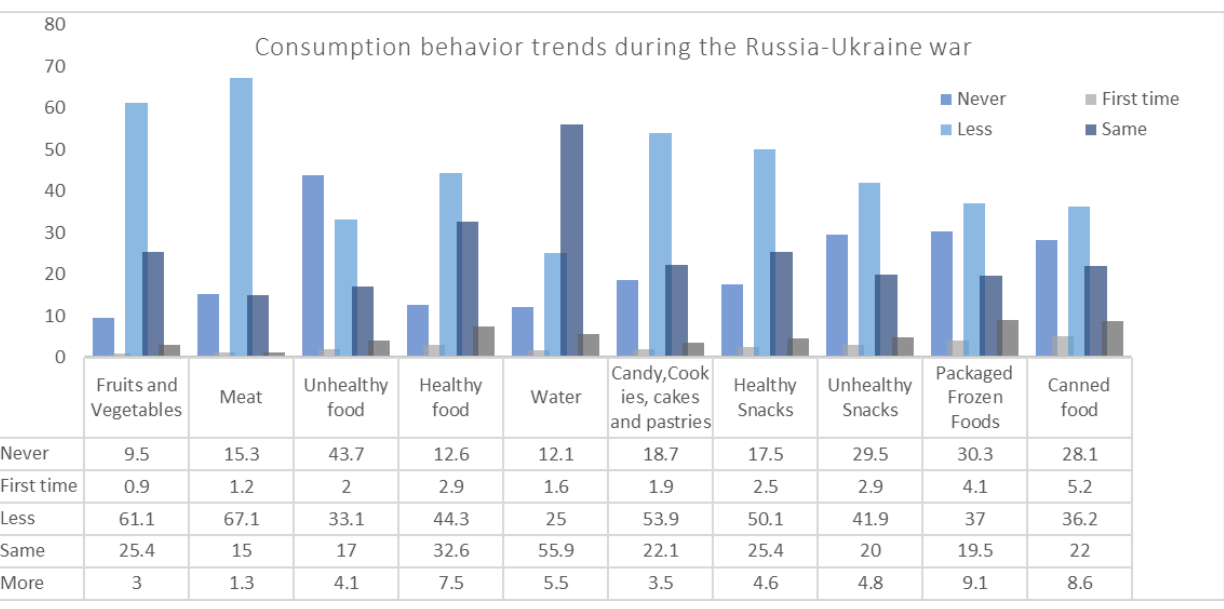
Figure 5. Changes in consumption behavior trends during the Russia-Ukraine war.